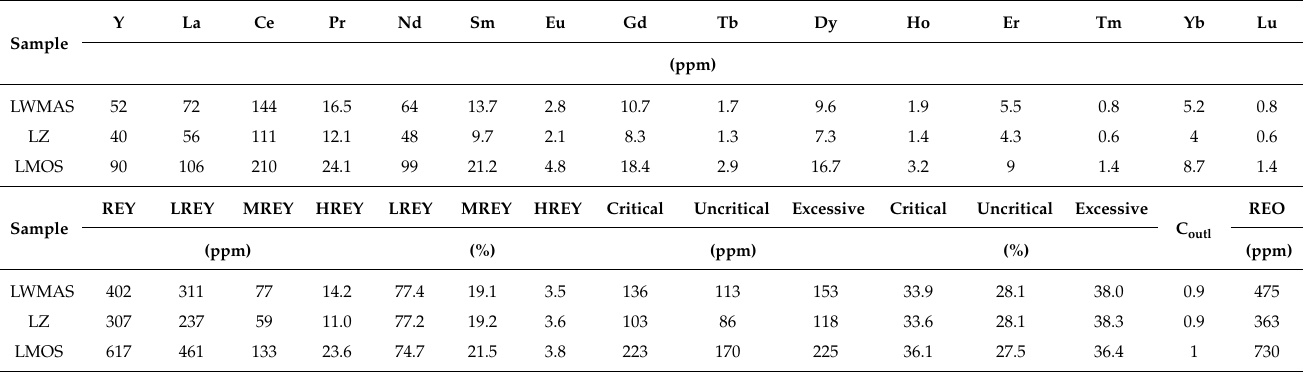
Table 4. The REY content in examined ash